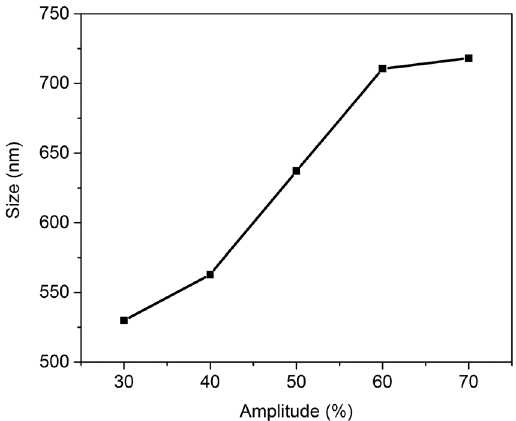
Figure 2: E ff ect of ultrasonic amplitude on the particle size of BSA/AM microcapsules.